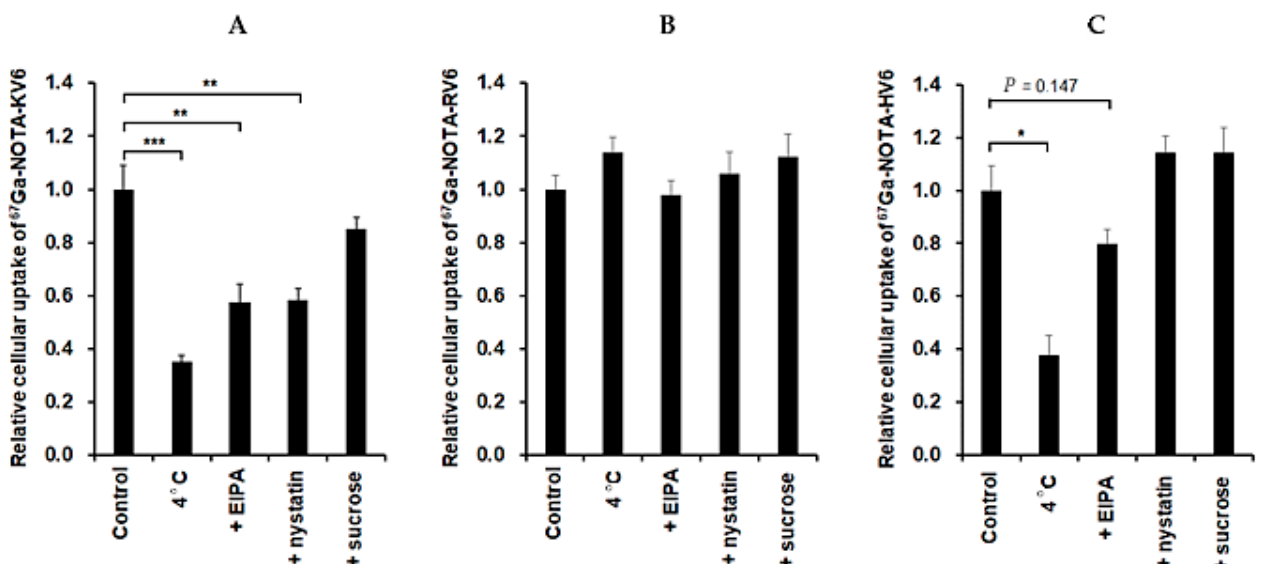
Figure 7. Cellular uptake inhibition of 67 Ga-NOTA-KV6 ( A ), 67 Ga-NOTA-RV6 ( B ), and 67 Ga-NOTA-HV6 ( C ) for 60 min in KB cells. Cells were incubated at 4 ◦ C to investigate energy-dependent uptake. Three different inhibitors: a macropinocytosis inhibitor (EIPA), a caveolae inhibitor (nystatin), and a clathrin inhibitor (sucrose) were used to investigate the effects of inhibition of endocytosis. * p < 0.001 ** p < 0.005, and *** p < 0.0001 compared with control (ANOVA Dunnett’s multiple comparison test). Values are mean ± SEM ( n = 12).